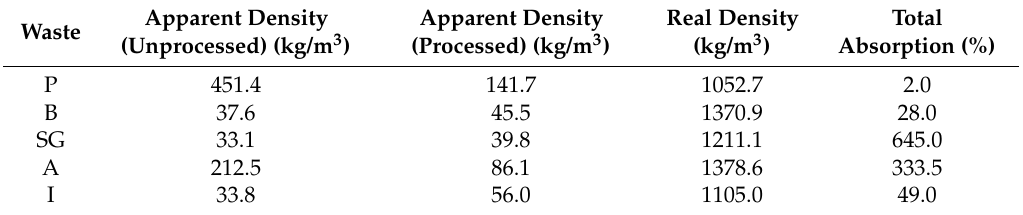
Table 3. Results of apparent density, real density, and total water absorption of different PU waste.